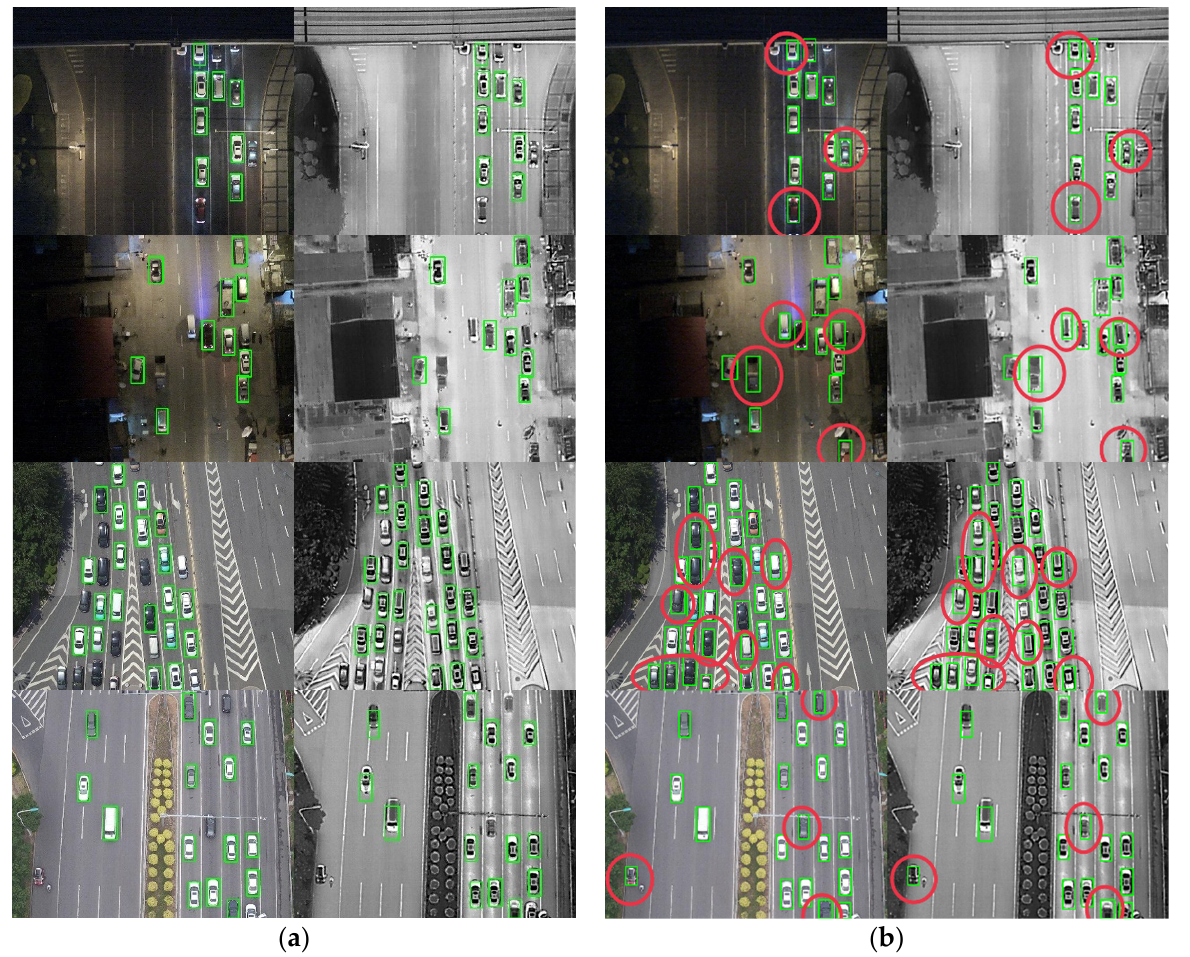
Figure 5. Visualization of baseline ( a ) and proposed RISNet ( b ) detection results on DroneVehicle remote sensing dataset. The first row shows the detection results in the daytime scenarios. Targets circled in red represent targets not detected by baseline but detected by RISNet.